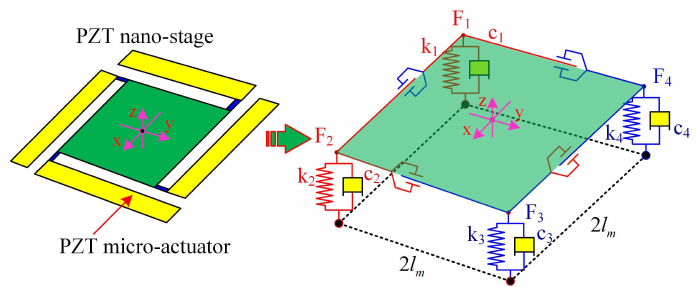
Figure 3. Schematic diagram of the flexible piezoelectric nano-positioning stage.